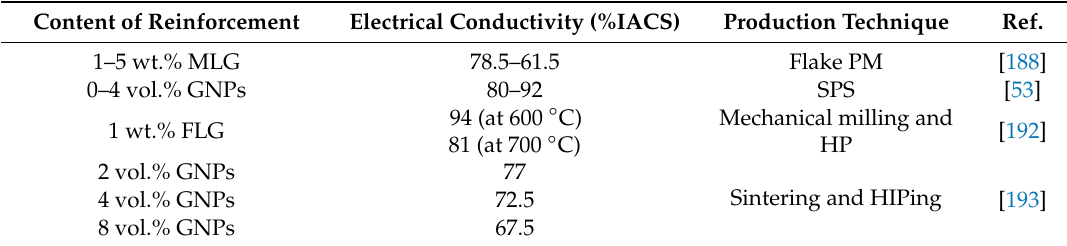
Table 8. A summary of the electrical conductivity of Cu–GNPs nanocomposites.